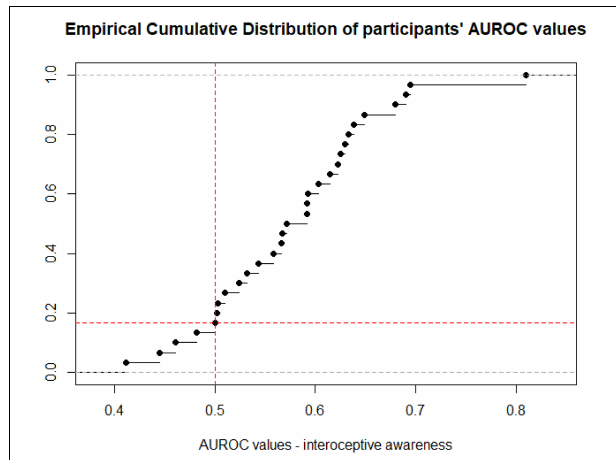
FIGURE 3 | Empirical cumulative distribution of participants AUROC values obtained by applying the ROC function to correct and incorrect responses predicted by confidence ratings in such answers. Red lines: vertical = 0.5, horizontal = 0.5 of the ECD. Gray lines: upper and lower boundaries of effect